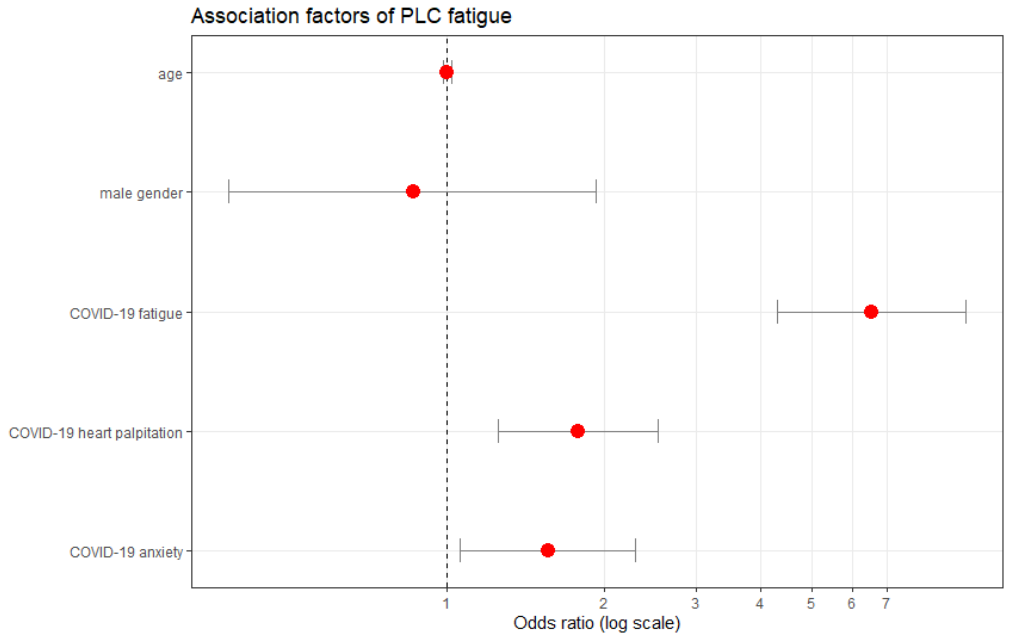
Figure 4. Probability of developing PLC fatigue, adjusted multivariable logistic regression analysis. Factors presented (except age and gender) are associated with a statistically significant ( p < 0.05) reduced probability (left-hand side from the indicated margin) or increased probability (right-hand side from the indicated margin) of developing PLC fatigue; PLC, post-acute COVID-19 syndrome; red dots represent the probability (odds ratio) of developing PLC